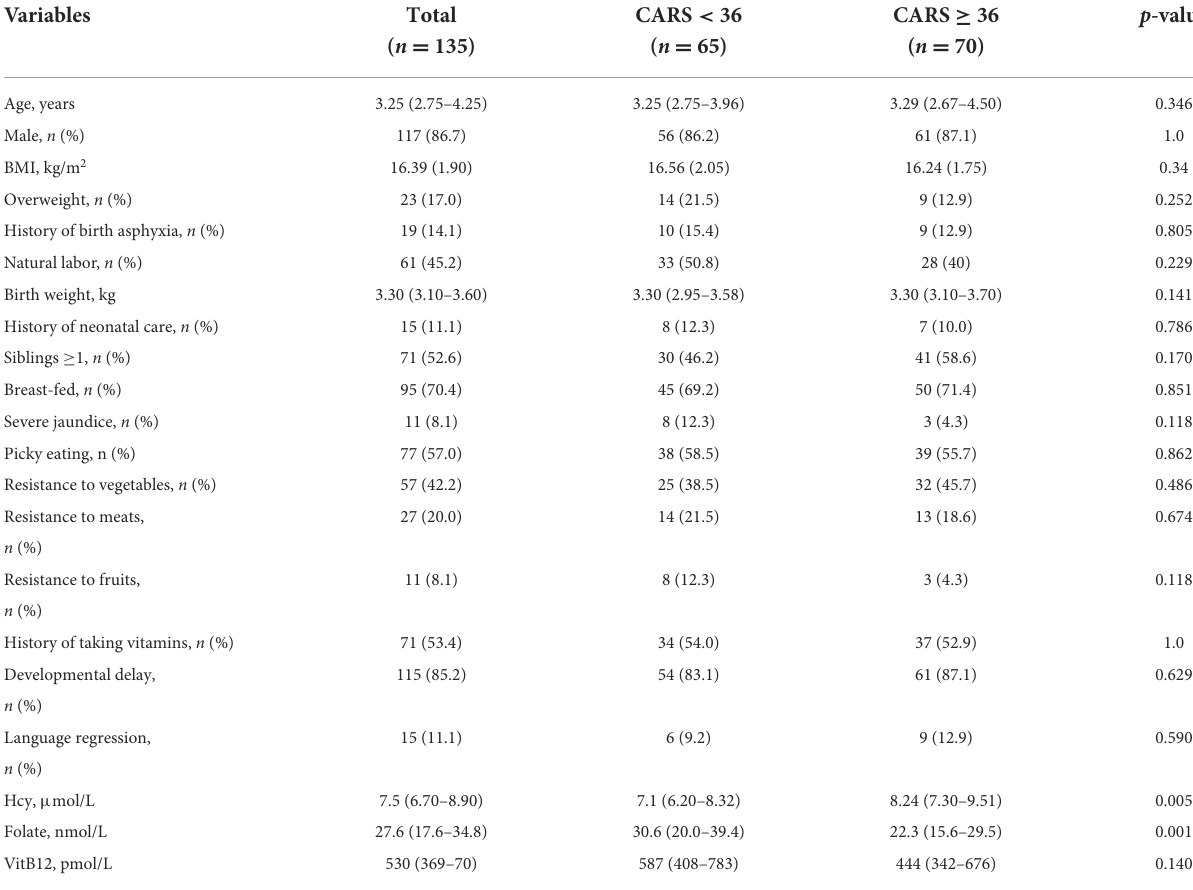
TABLE 2 Baseline characteristics of patients with ASD grouped by severity of clinical symptoms according to CARS.